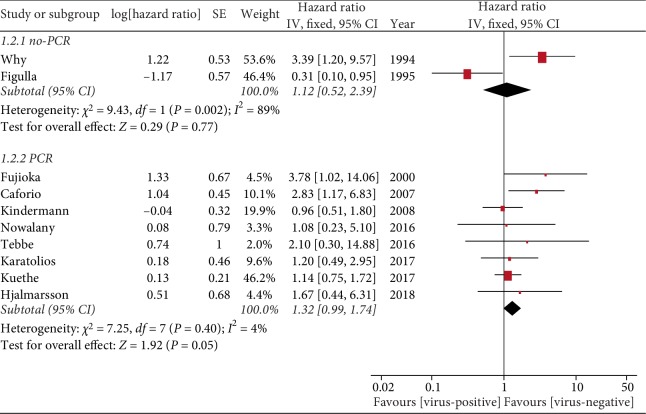
Virus detection methods.